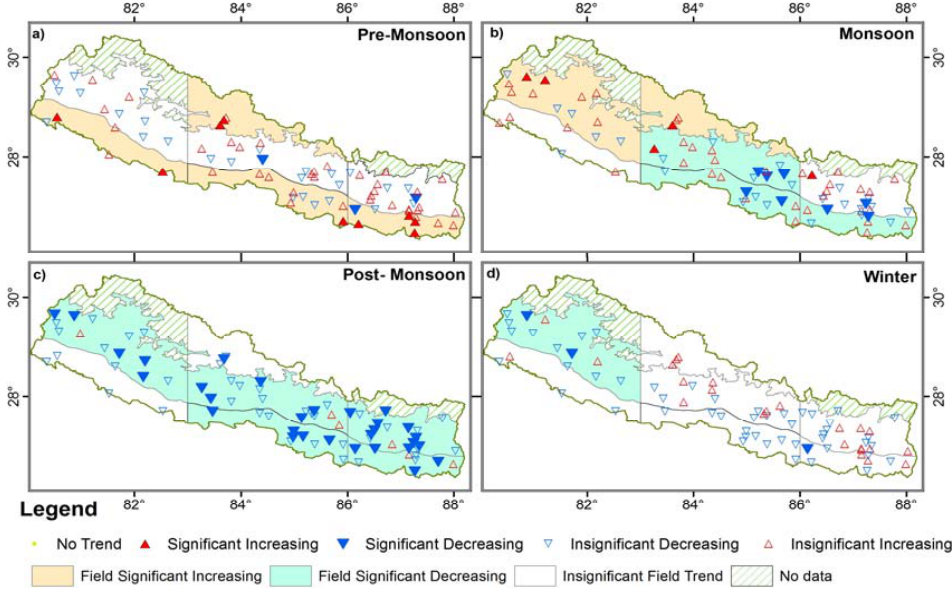
Figure 5. Stationwise and field significant trends of seasonal precipitation total for ( a ) Pre monsoon; ( b ) Monsoon; ( c ) Post monsoon; and ( d ) Winter season (significance at 0.1).